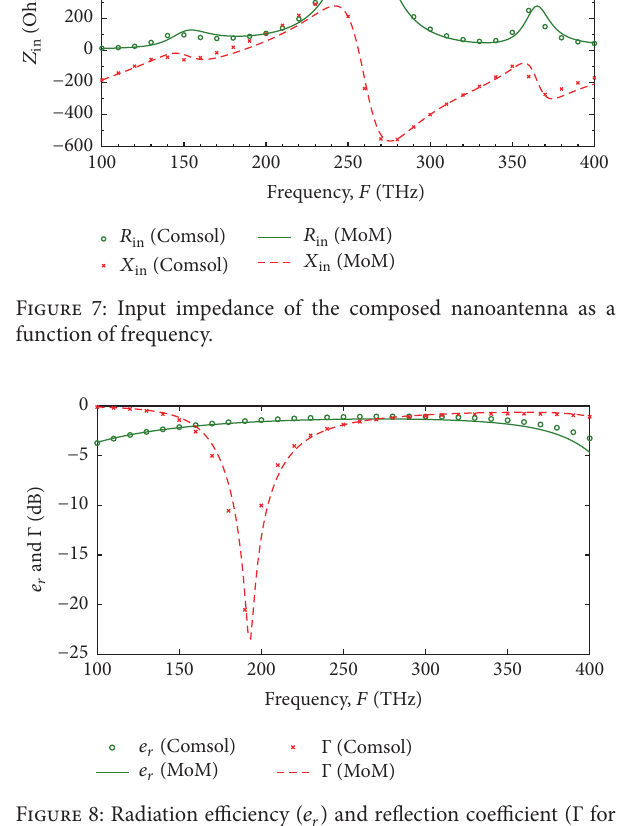
Figure 8: Radiation efficiency ( 𝑒 𝑟 ) and reflection coefficient ( Γ for Ω ) of the isolated electrical nanodipole as a function of 𝑍 0 = 60 frequency, calculated by MoM and